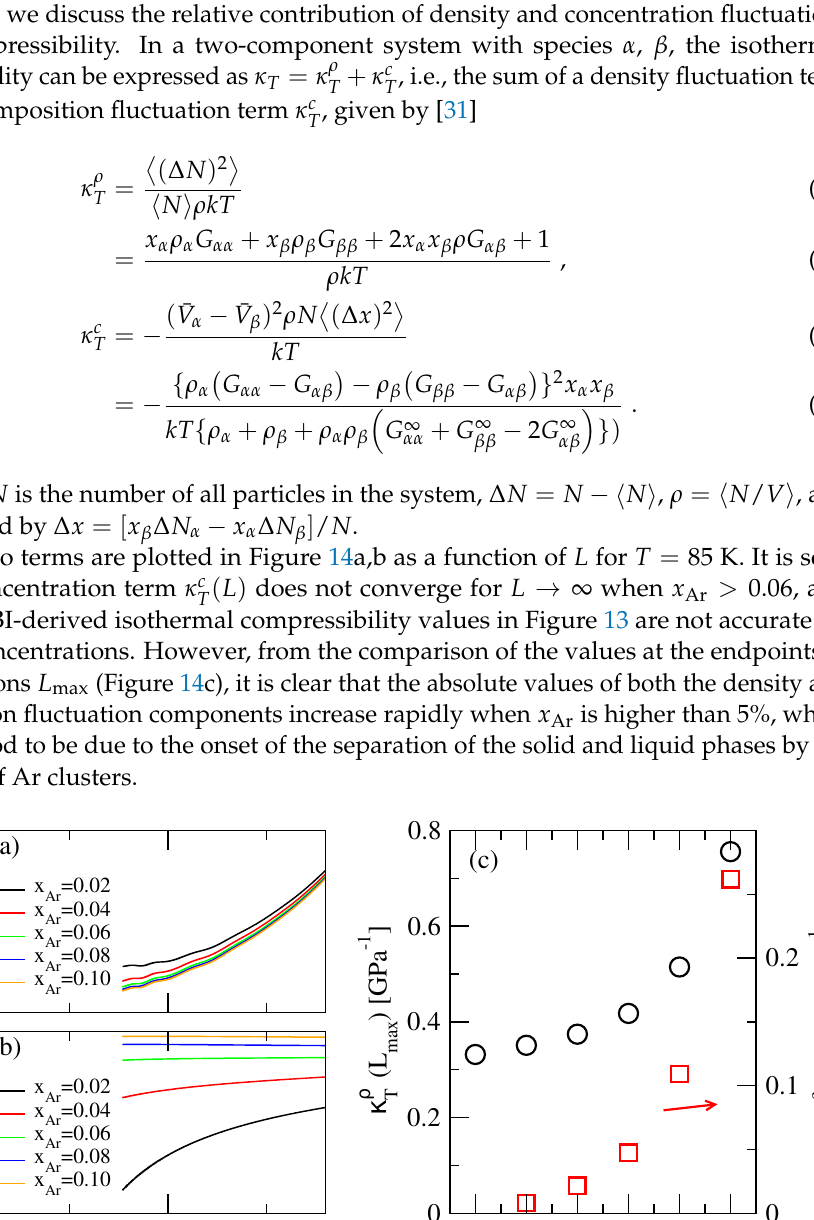
( L ) (Equation (27)). ( c ) The absolute values of the endpoints T